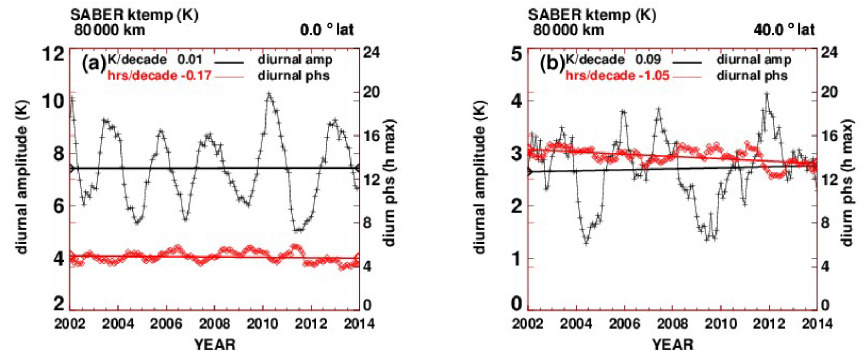
Figure A4. (a) Temperature tidal diurnal amplitudes and phases at 80km and the Equator. On the left axis scale, black line: tidal diurnal amplitude (K). On the right axis scale, red line: diurnal phase (h of maximum value). (b) As in (a) but at 40 ◦ N latitude.